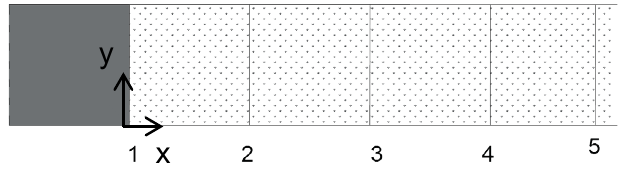
Fig. 3 Measurement sections – WV